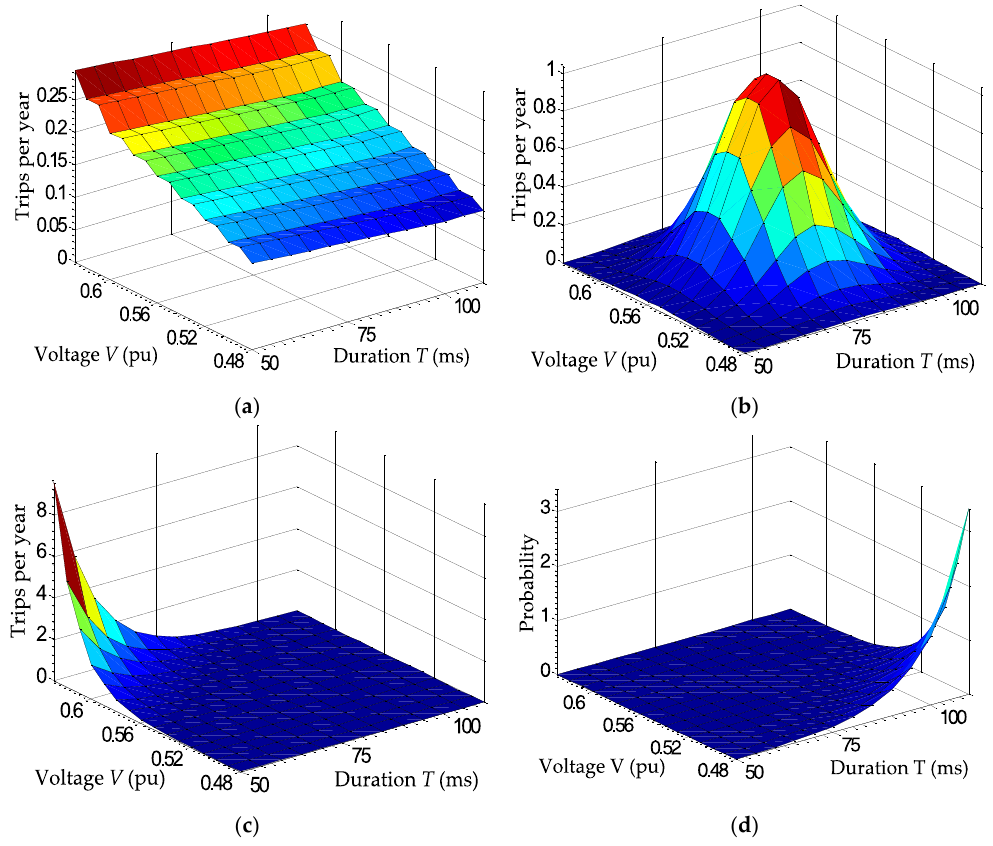
Figure 14. Number of expected trips a year of various voltage–tolerance characteristics for PC: ( a ) uniform; ( b ) normal; ( c ) exponential; and ( d ) reverse exponential.